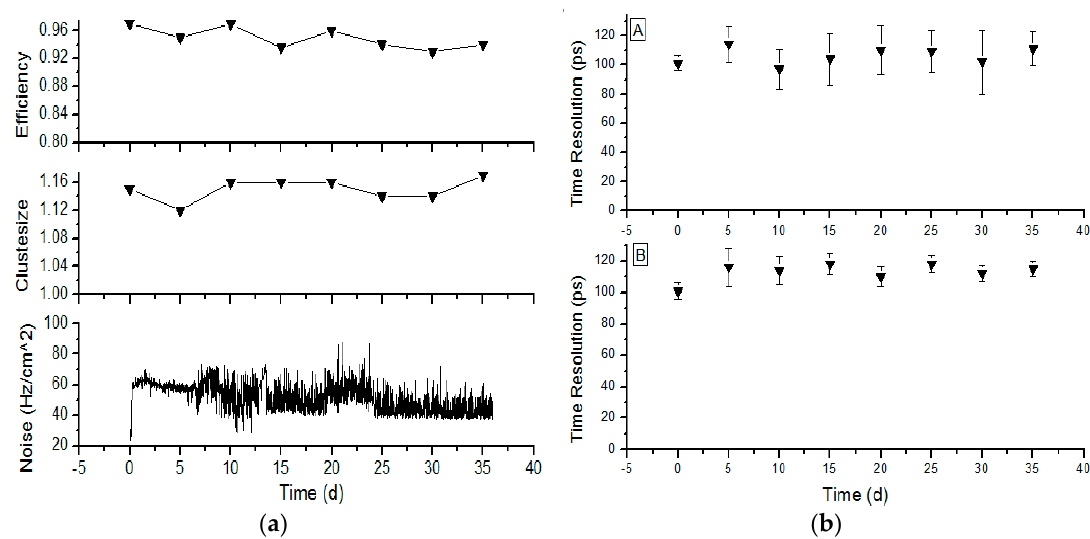
Figure 8. Efficiency, cluster size, noise ( a ) and time resolution ( b ) with irradiation time. In ( b ) the time resolution is analyzed by two methods: label ( A ) is the results for every 5 days and label ( B ) is the results with time. Reproduced with permission from Wang et al., Chinese Physics C; published by Chinese Physical Society and the Institute of High Energy Physics of the Chinese Academy of Sciences and the Institute of Modern Physics of the Chinese Academy of Sciences and IOP Publishing Ltd, 2016 [72].